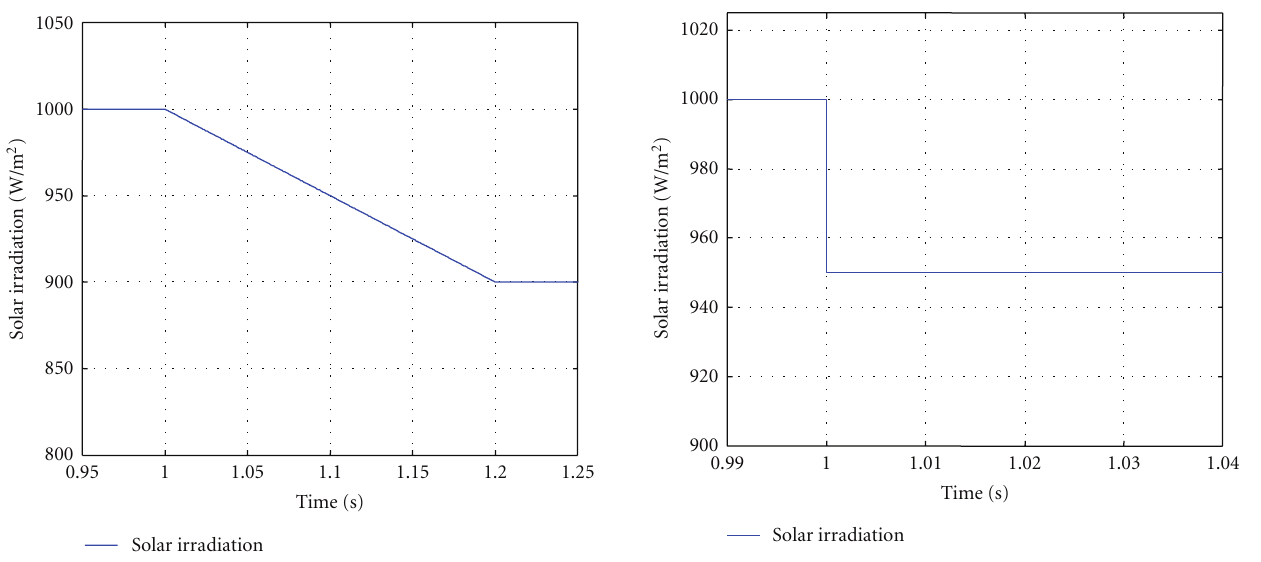
Figure 16: Drastic change in irradiation from 1000W/m 2 to 950 W/m 2 .